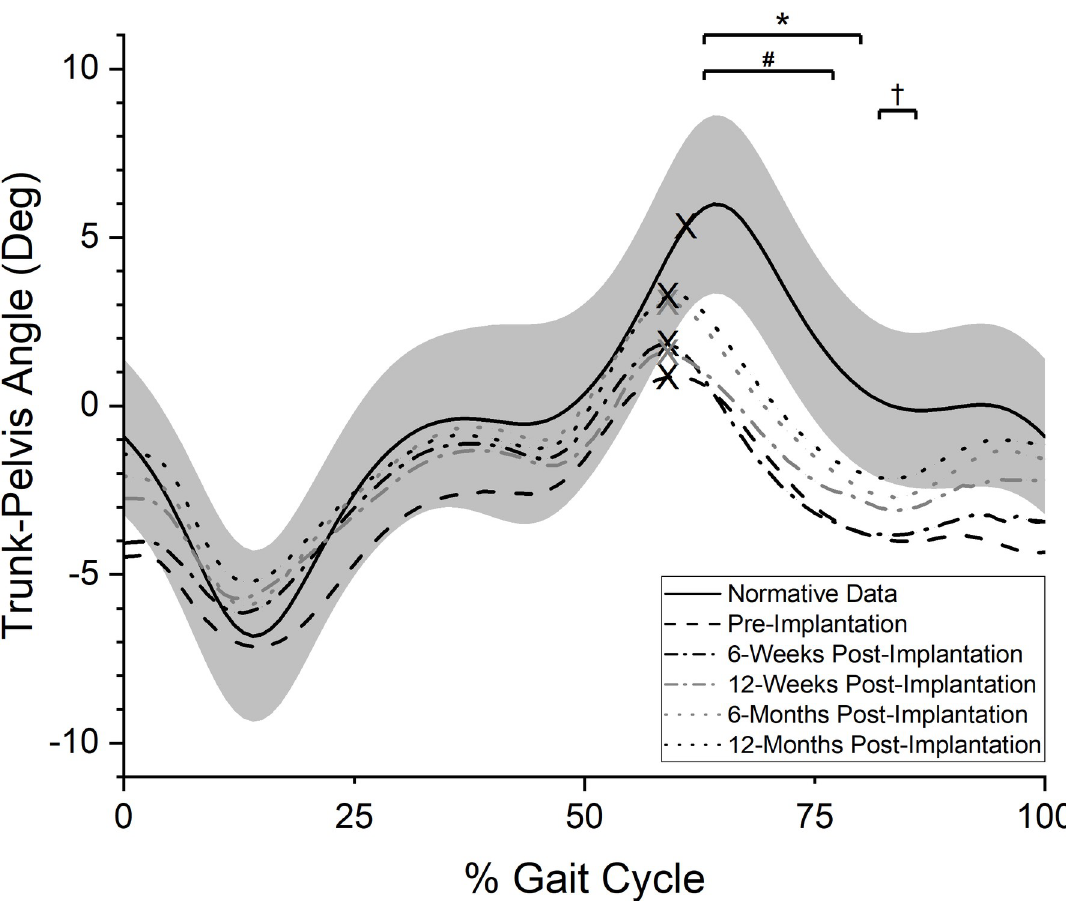
Fig 5. Frontal plane trunk-pelvis angle. Averaged, normalized frontal plane trunk-pelvis angle values over the prosthetic side gait cycle (0% = POP side heel strike, 100% = subsequent POP side heel strike). “X” marks represent the mean toe-off event for each curve. Positive values indicate ipsilateral shoulder elevation relative to pelvis (increased trunk-pelvis angle), while negative values indicate ipsilateral shoulder declination relative to the pelvis (decreased trunk-pelvis angle). Solid black line indicates reference values for individuals without TFA while grey band indicates plus or minus one standard deviation of the reference data. � : period of statistically significant difference in pre-implantation test values from reference data (p = 0.03); #: period of statistically significant difference in 6-week post-implantation test values from reference data (p = 0.04); †: period of statistically significant difference in 12-month post- implantation test values from reference data (p = 0.07).